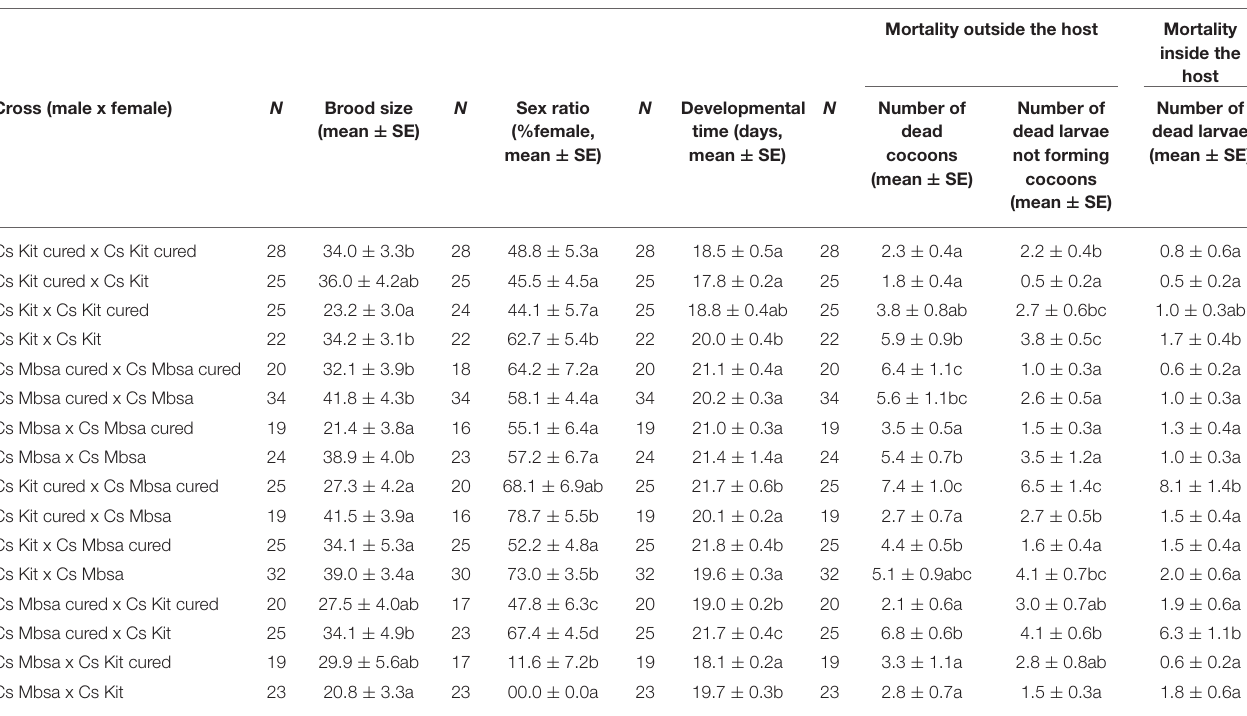
TABLE 5 | Brood size, sex ratio, developmental time and mortality outside and inside the host of populations of different crosses on Sesamia calamistis ( N = number of replicates).